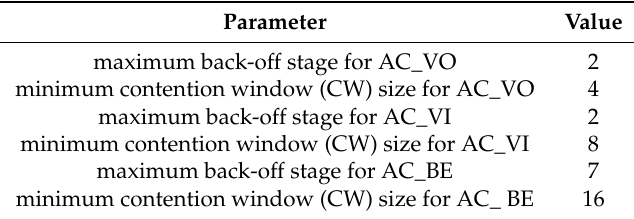
Table 2. Parameters for the virtual back-off